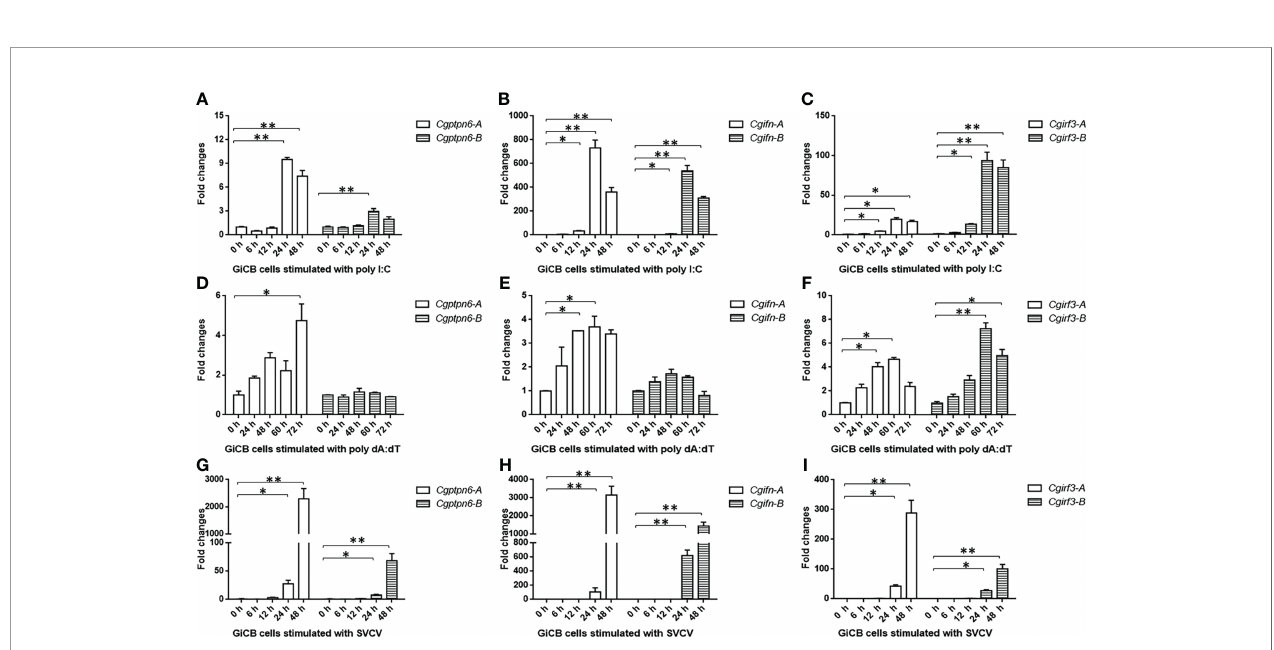
FIGURE 3 | Dynamic expression changes of Cgptpn6-A and Cgptpn6-B , Cgifn-A and Cgifn-B , Cgirf3-A and Cgirf3-B stimulated by 1 m g poly I:C (A – C) , poly dA:dT (D – F) or SVCV (MOI = 1) in GiCB cells (G – I) by qPCR analyses. eef1a1l1 was used as an internal control for normalization and the relative expression is represented as fold induction relative to the expression level in control cells. Each bar represents mean ± standard deviation (SD) (n = 3). Asterisks indicate signi fi cant differences from control (* p < 0.05, ** p <